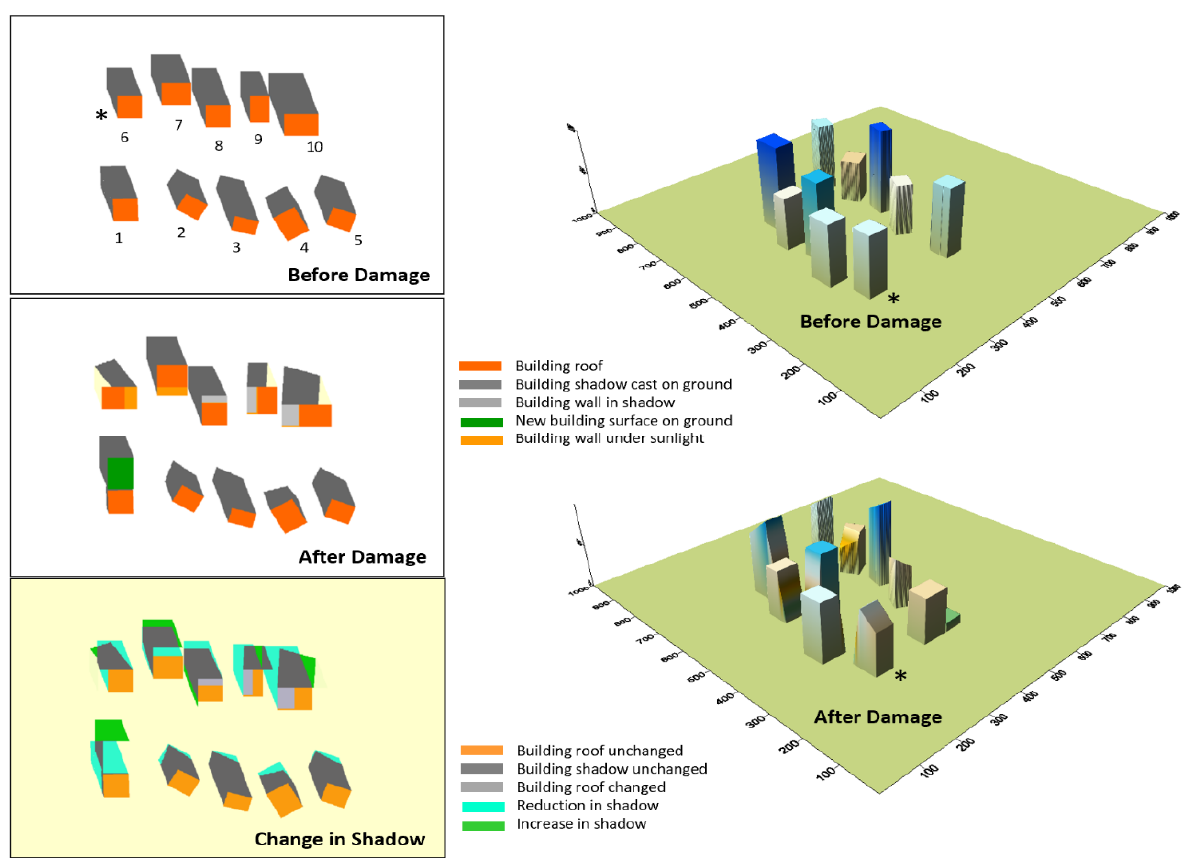
Figure 6. Building DSM maps in 3D ( right ), building shadows, and changes for the before- and after-damage scenario ( left ) for the Case A study. The mark ‘*’ indicates the location of a building in different pictures.